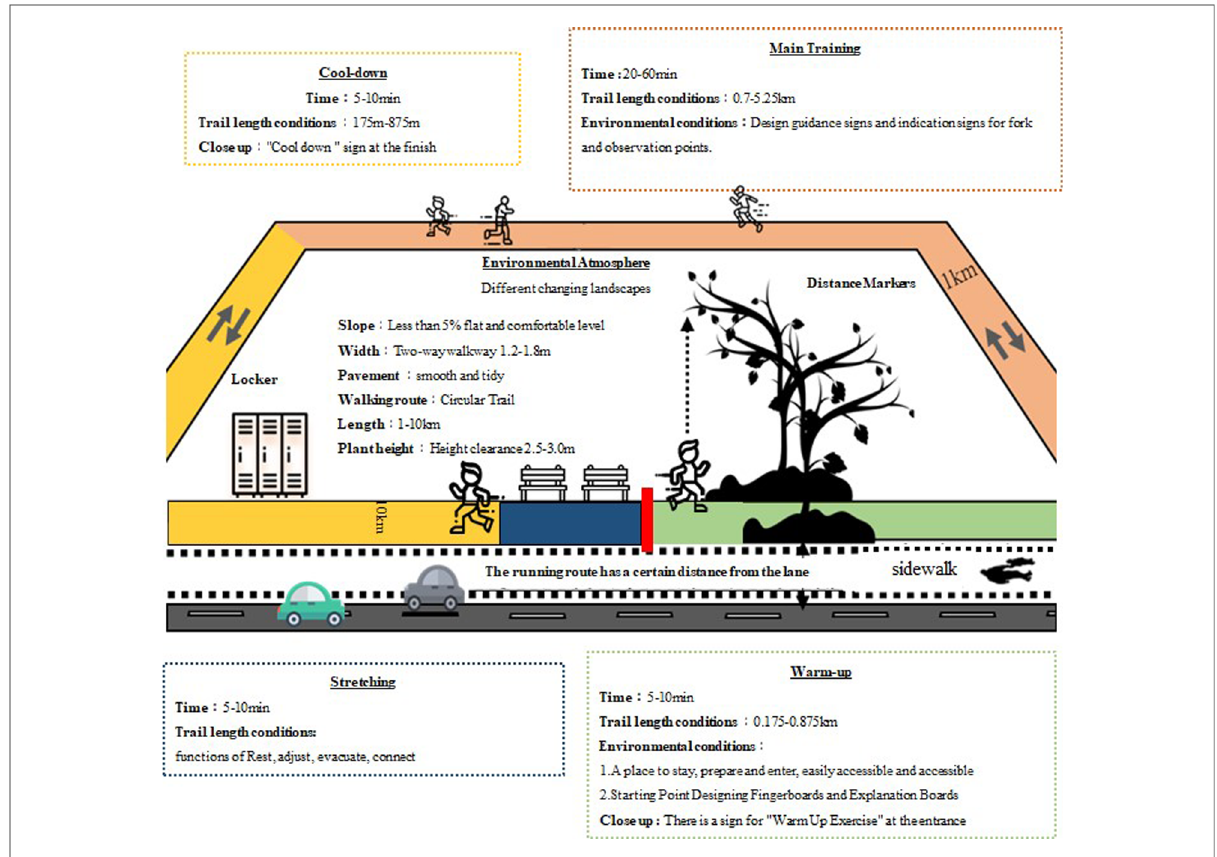
FIGURE 5 Outdoor environment elements needed for moderate cardiorespiratory fi tness